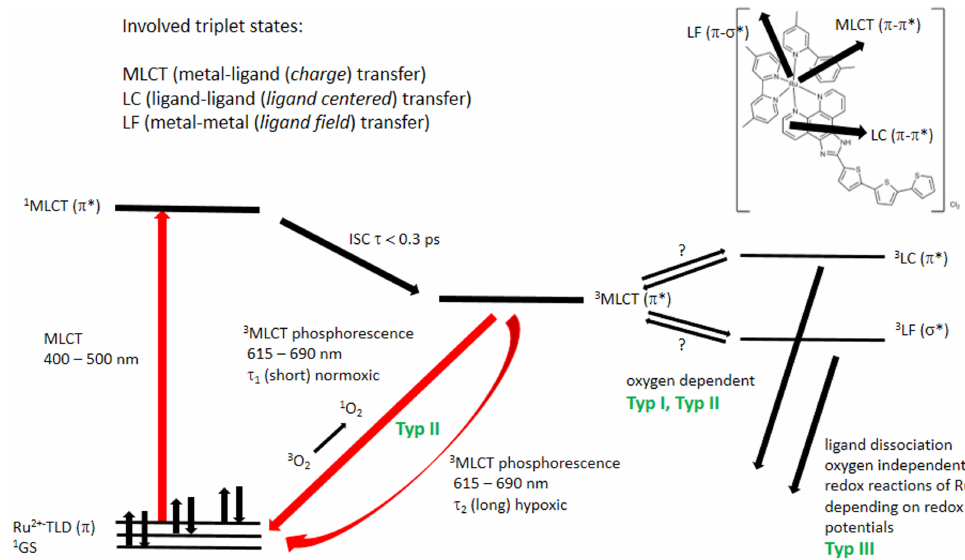
Fig. 1. A possible Jablonski diagram of Ru(II)